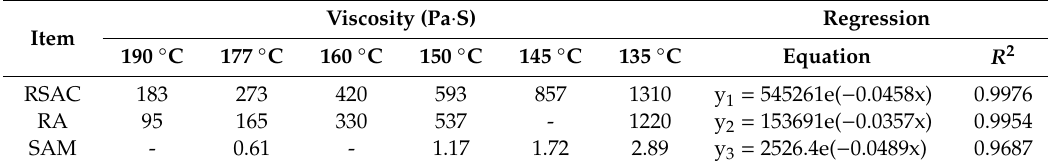
Table 4. Viscosity of di ff erent asphalt binders and mortars at di ff erent temperatures.